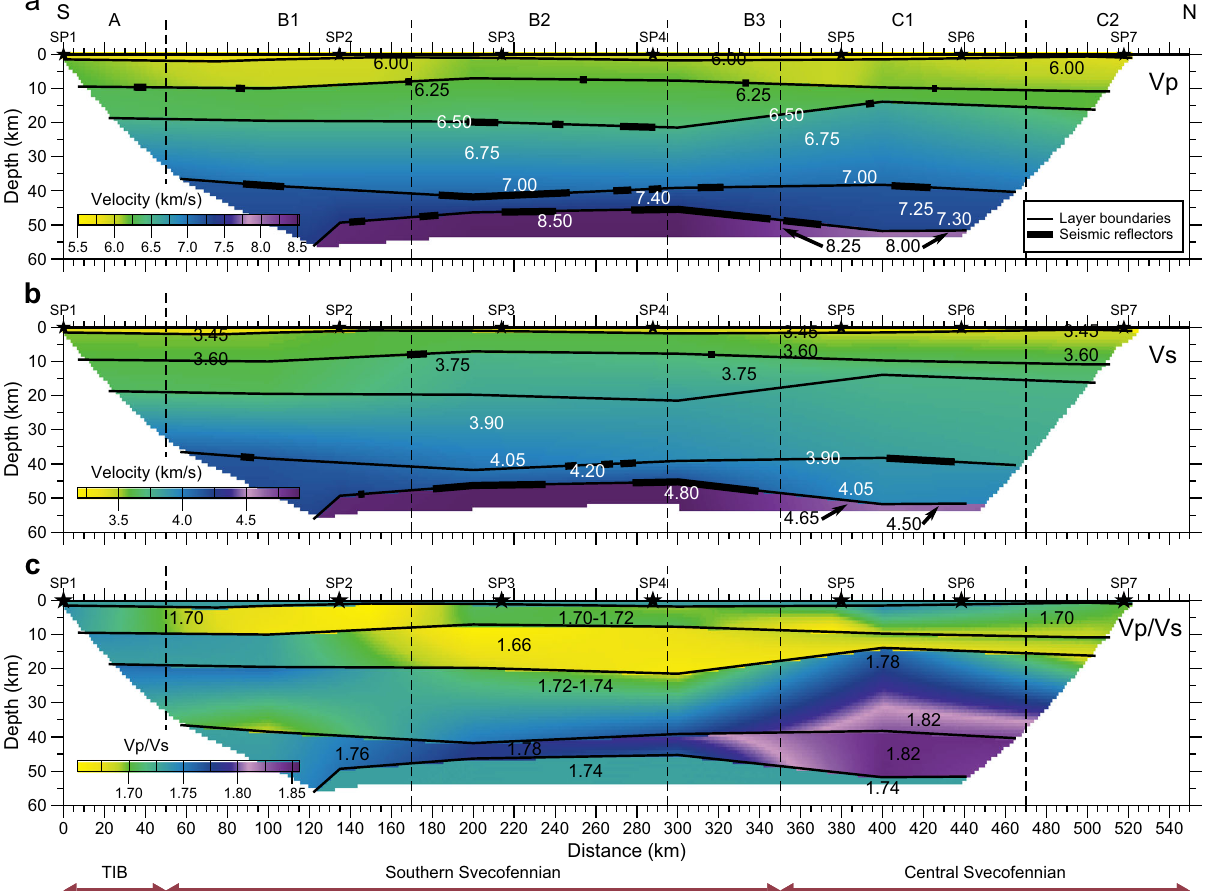
Fig. 2 Seismic models along the pro fi le. a P- and b S-wave velocity and c Vp/Vs ratio along the seismic pro fi le. Seismic sources (SP1 – SP7) — black stars; tectonic units as in Fig. 1. Velocity discontinuities — dashed lines; identi fi ed seismic re fl ections — thick black lines (shown in a , b